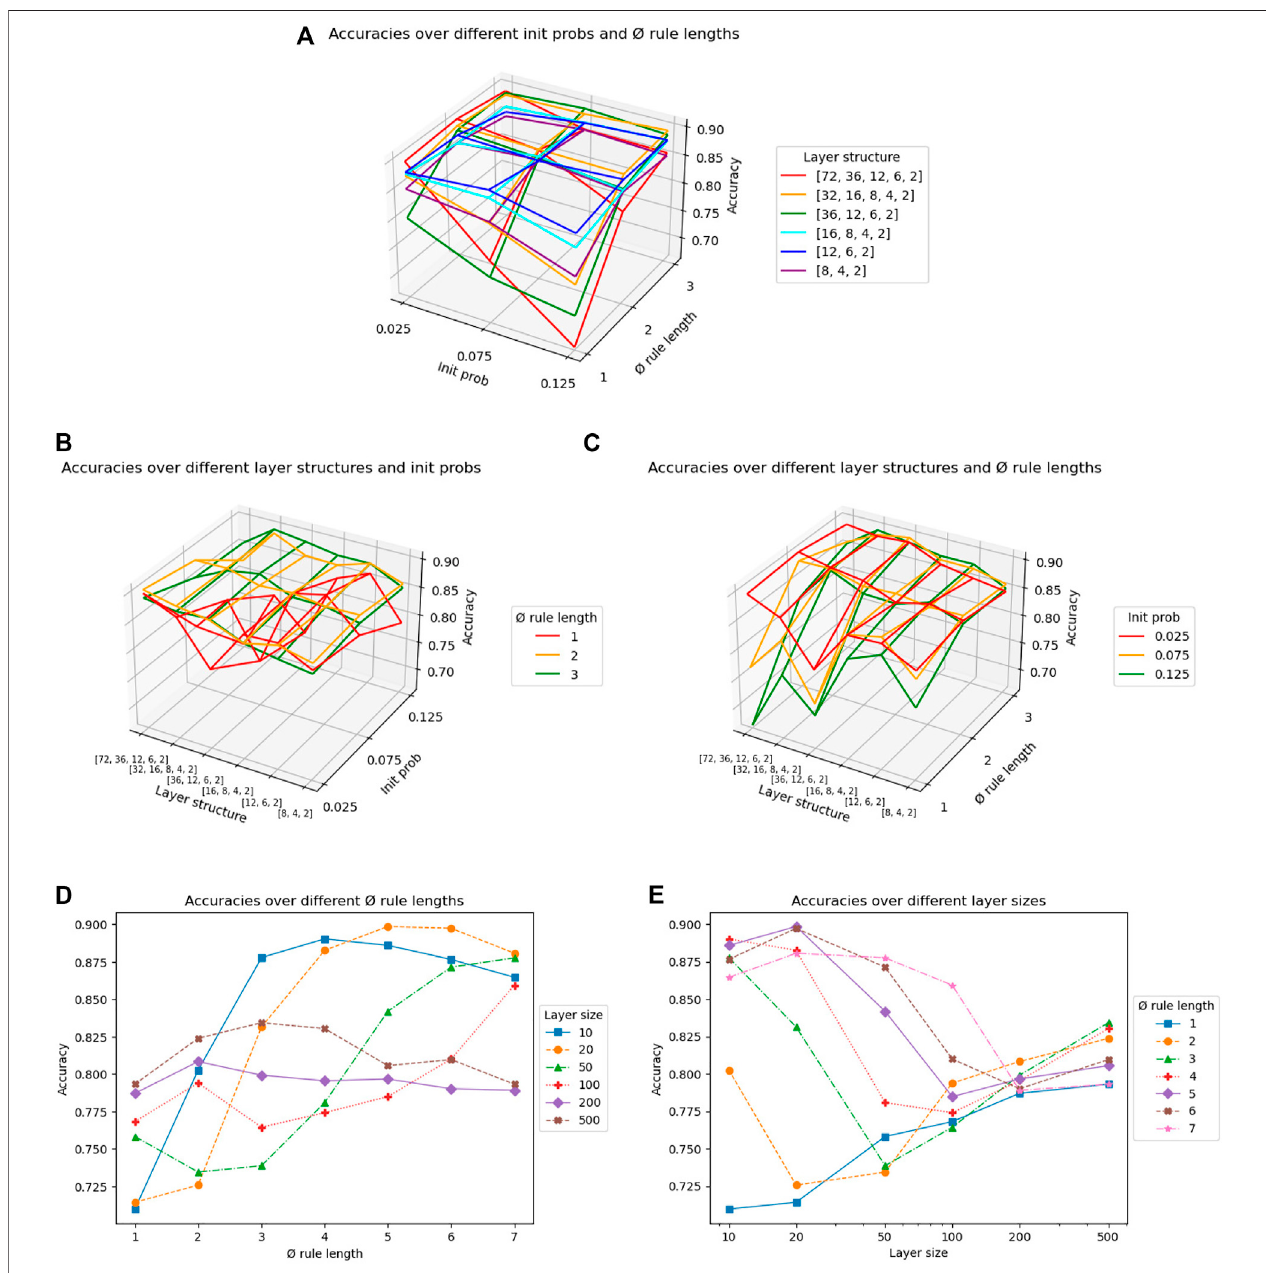
FIGURE 5 | Grid search on the hyperparameters average rule length (cid:1) l , initialization probability p , number n and sizes s i of hidden layers. The fi rst three plots show accuracies fordeep rulenetworkswith different combinationsof (A) p and (cid:1) l , (B) n | s i and (cid:1) l and (C) n | s i and p .The last twoshow accuracies for shallow rule networkswith different (D) (cid:1) l and (E) s 1